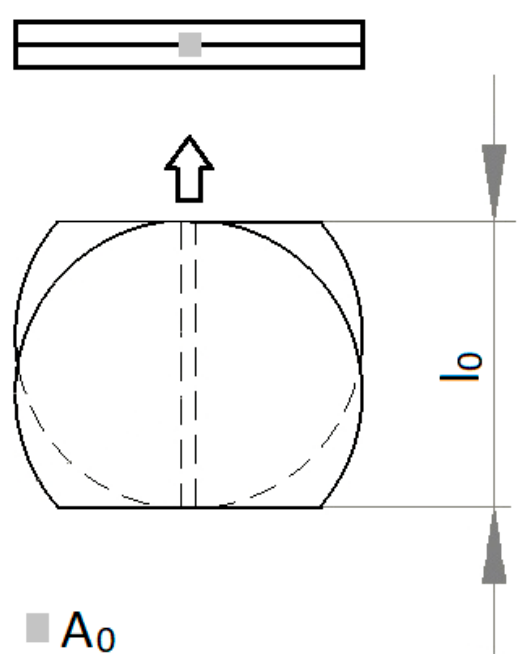
Figure 3. Drawing illustrating the specimen original dimensions and cross-section.